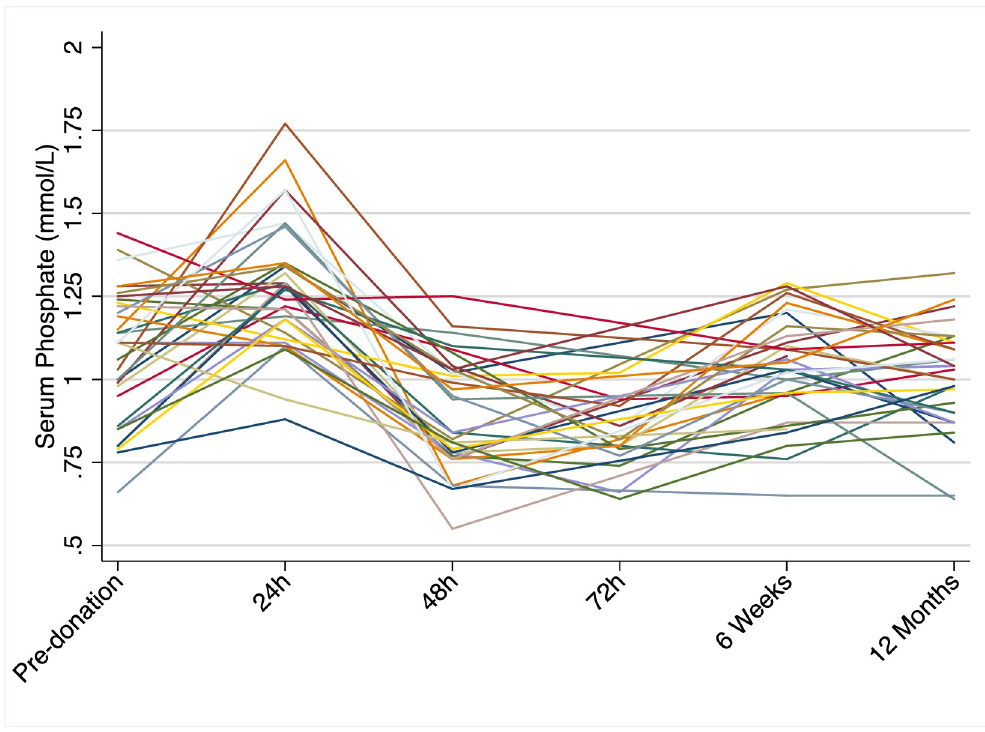
Fig 4. Individual patient phosphate